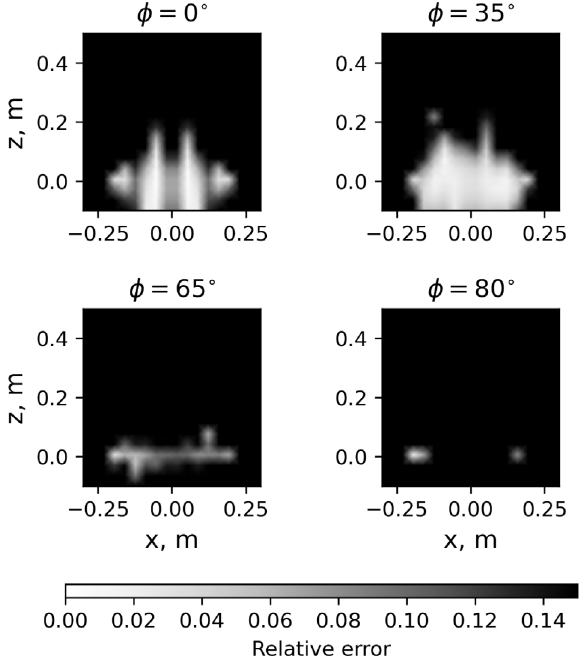
Figure 5. Error between target and simulated sound pressure fi elds in the xz plane ( y = 0) at 1500 Hz for various plane wave incidences / and for azimuthal angle h = 50 (cid:3) , with regularization parameter k = 10 (cid:3) 5